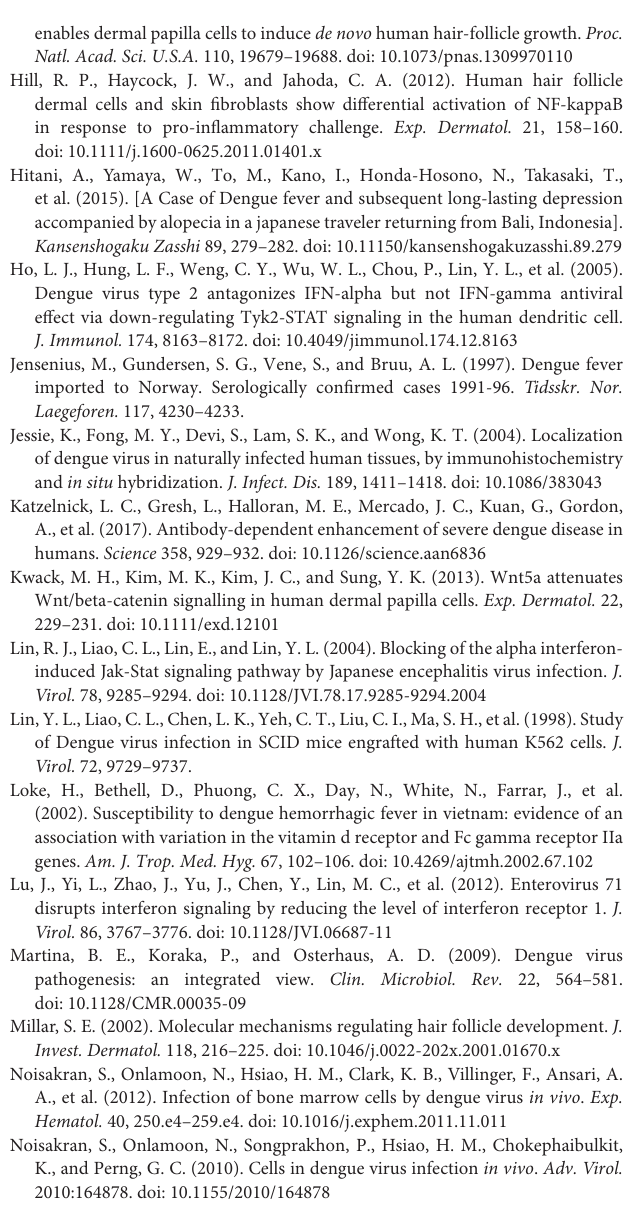
Table S1 | qPCR primer sequences used in this study. Figure S1 | The expression of human Fc gamma receptors in HFDPCs. Figure S2 | Induction of IL-1 β , IL-6, and IL-8 expression and the DENV-2 5 ′ -UTR by various MOI (0.1–10) of DENV-2. Figure S3 | The full images of western blotting. Figure S4 | Reduction of ALPL, LEF1, NOG, and WNT5A expression by DENV-1 and DENV-2. Figure S5 | RT 2 profiler PCR Array analysis of DENV-triggered cell-death signaling